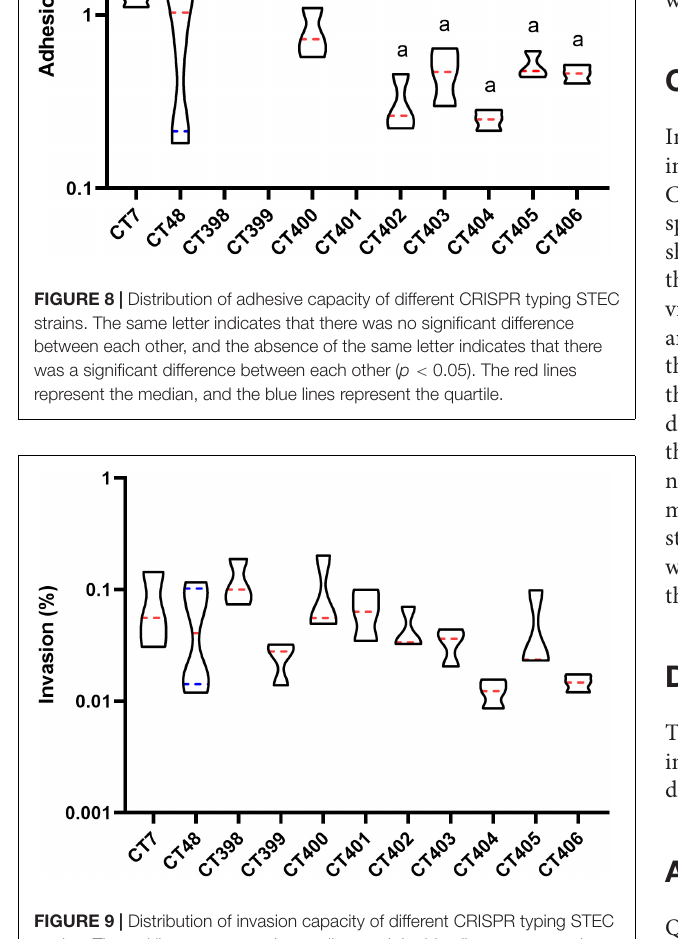
FIGURE 9 | Distribution of invasion capacity of different CRISPR typing STEC strains. The red lines represent the median, and the blue lines represent the